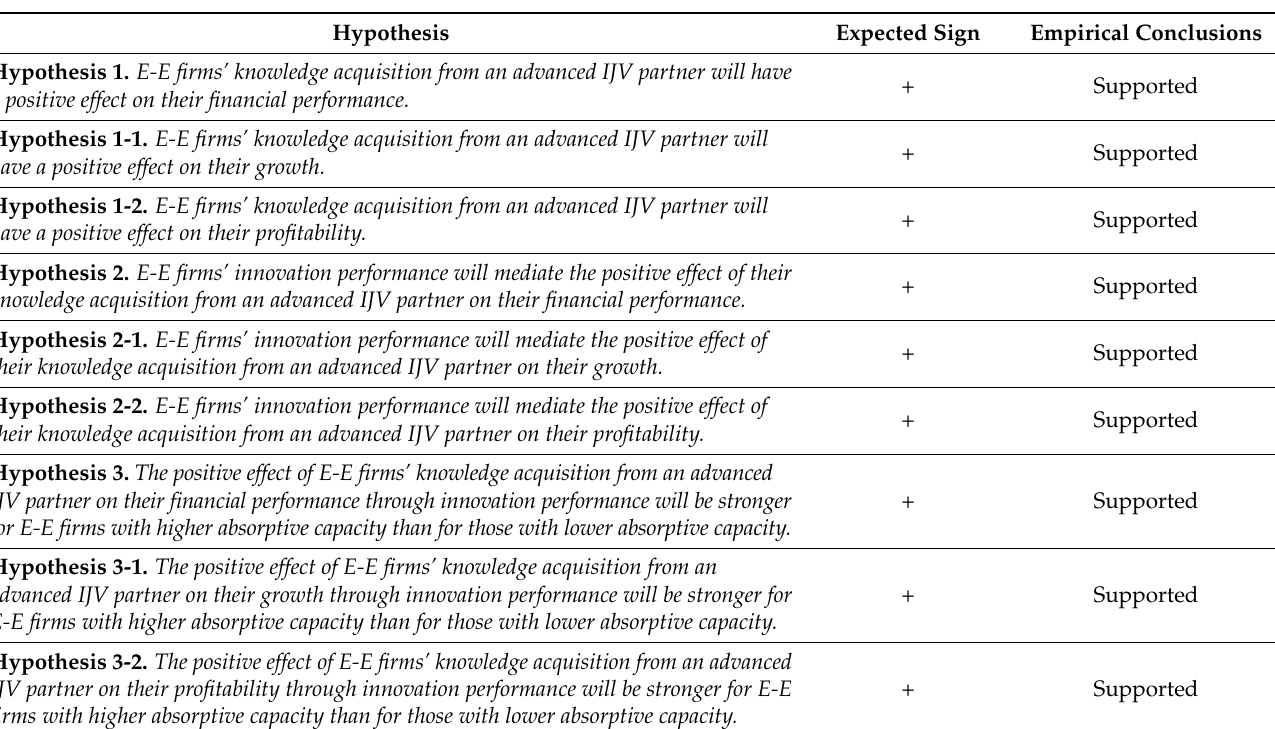
Table 5. Summary of hypotheses and empirical conclusions. Expected Sign Empirical